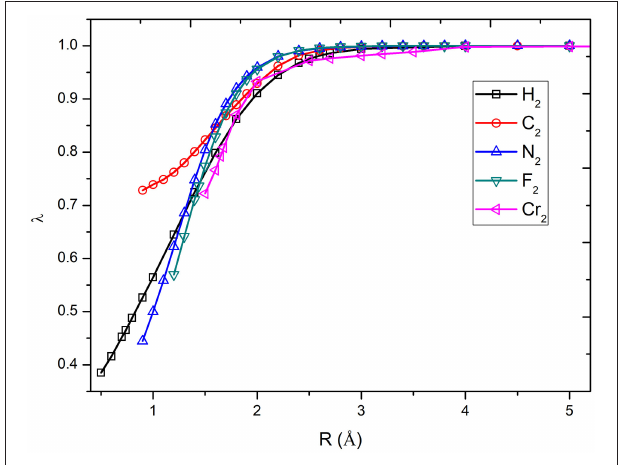
FIGURE 2 | The curves of λ as functions of bond distances for diatomic molecules.